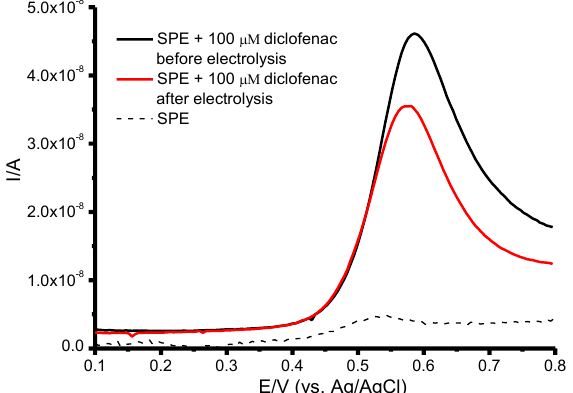
Figure 4. Differential pulse voltammetry (DPV) of diclofenac (100 µ M) before (-) and after electrolysis (-). SPEs were used for diclofenac registration ( . . . ). Electrolysis of diclofenac was performed on SPE/DDAB/P450 2C9, at the potential of electrolysis E = − 0.55 V, 20 min.